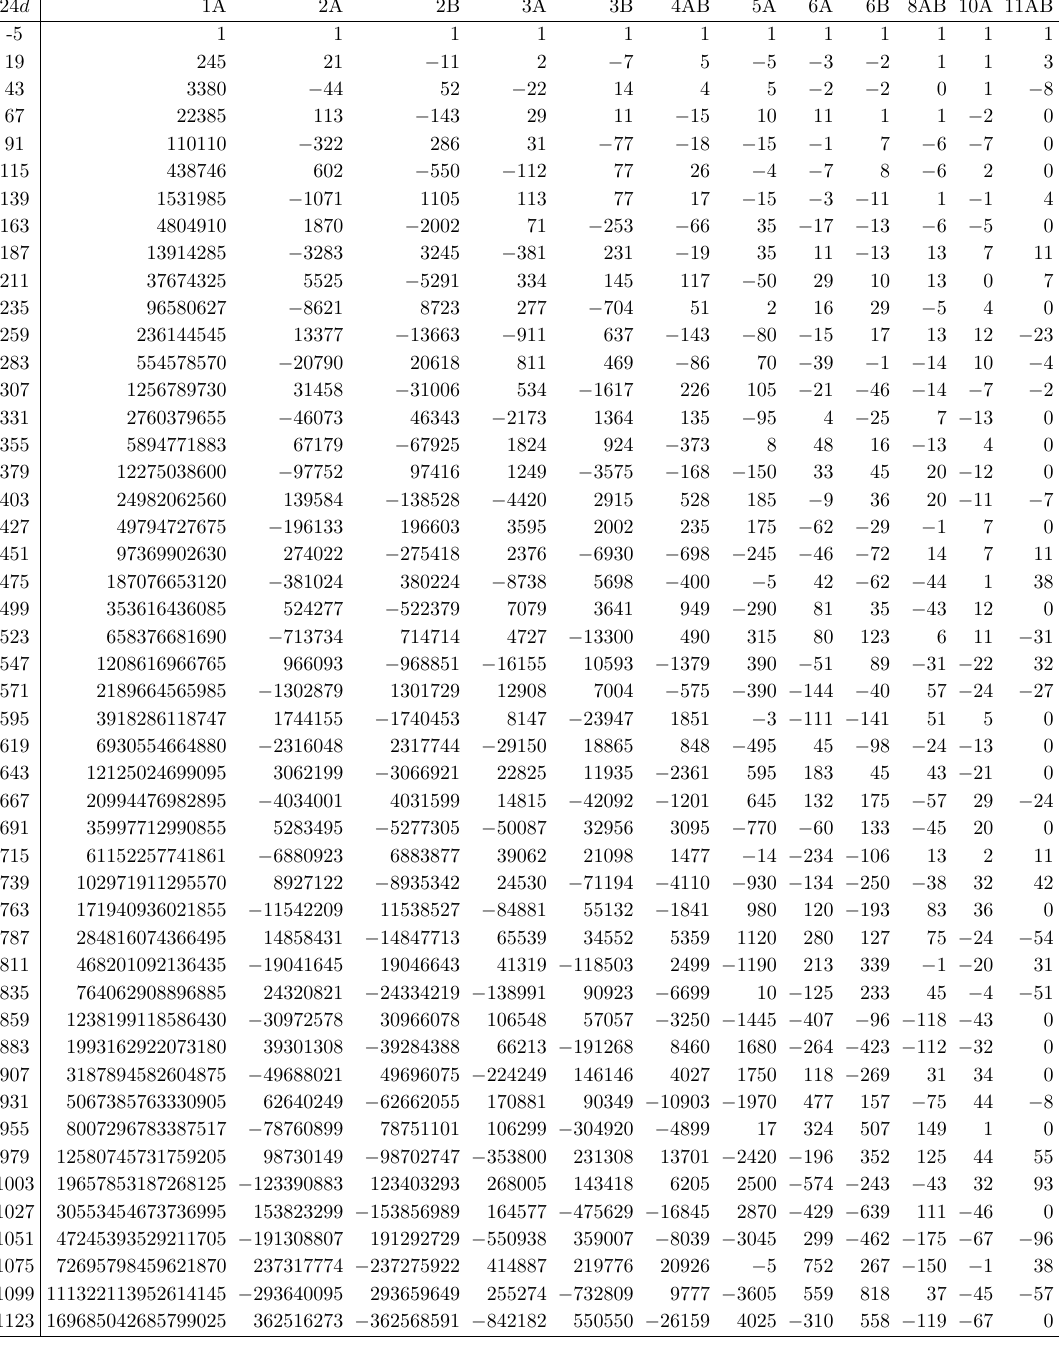
Table 2 . McKay-Thompson series f (1)